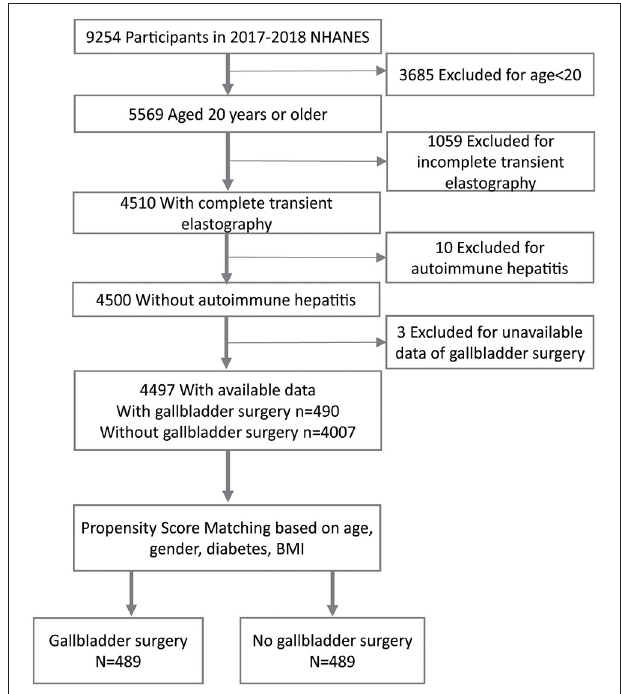
FIGURE 1 | A flowchart showing the selection of study participants. BMI-Body Mass Index.